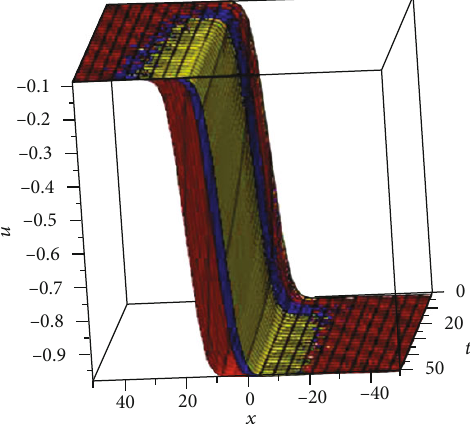
Figure 1: 3D plot of solutions (60a) and (60b) for various values of α , and c = 1/2